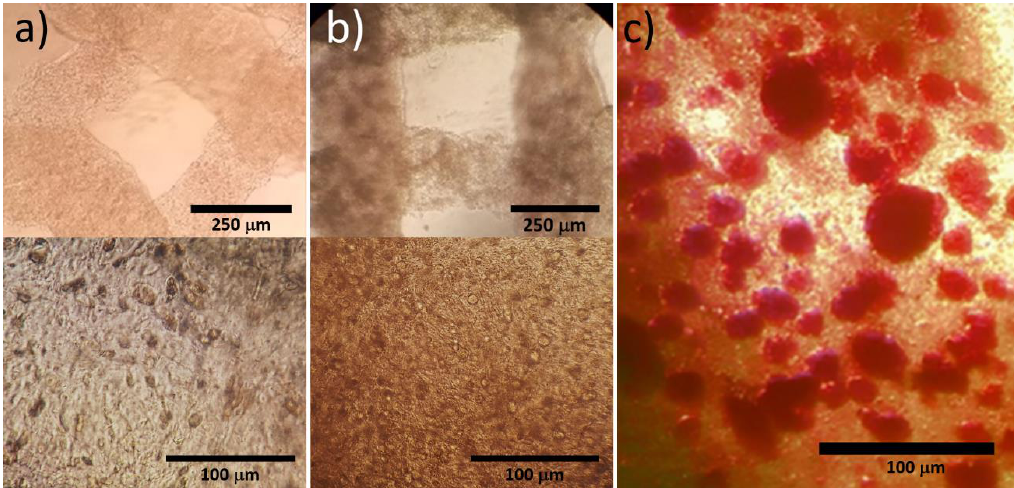
Figure 4. Optical microscope images of 3D-bioprinted osteoblast constructs after cryopreservation: ( a ) representative MG-63 construct, ( b ) representative Saos-2 construct and ( c ) positive Alizarin red S staining of a Saos-2 construct, showing in red colour the salts of calcium minerals. The samples were cryopreserved at day 3 of culture and the images were obtained after 7 days of culture.